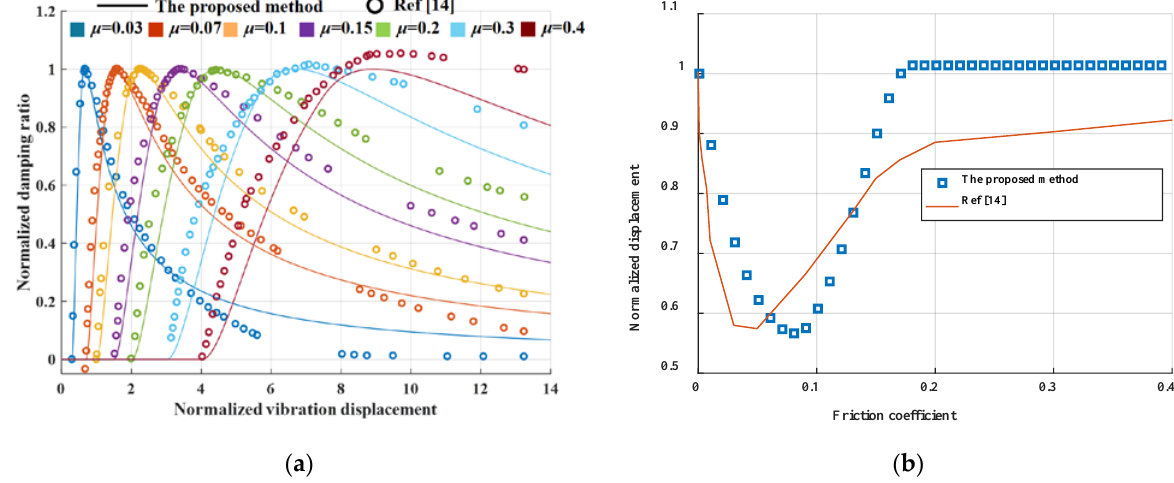
Figure 25. Comparison of the proposed method with ref [14]: ( a ) Normalized damping ratio along with normalized vibration displacement; ( b ) Normalized displacement along with friction coefficient.